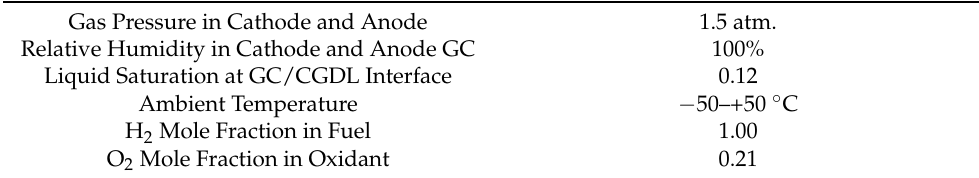
Table 5. Operating conditions of the base